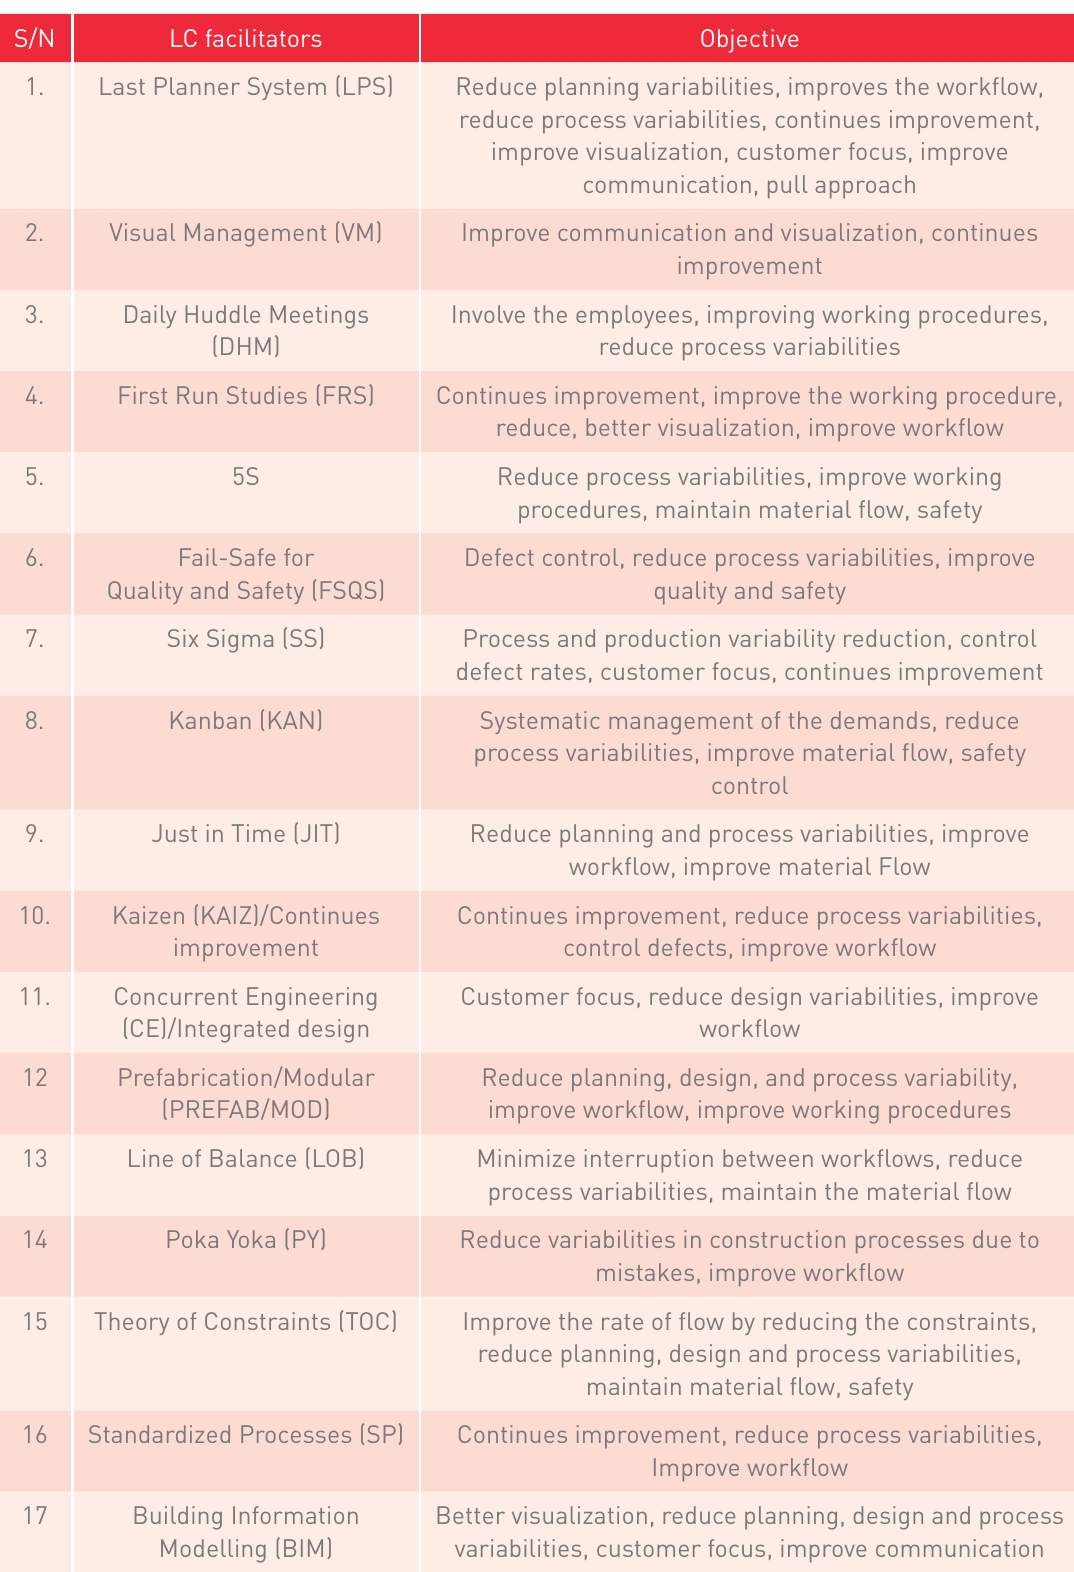
Table 2. Commonly used LC practices (Aslam, Gao and Smith,